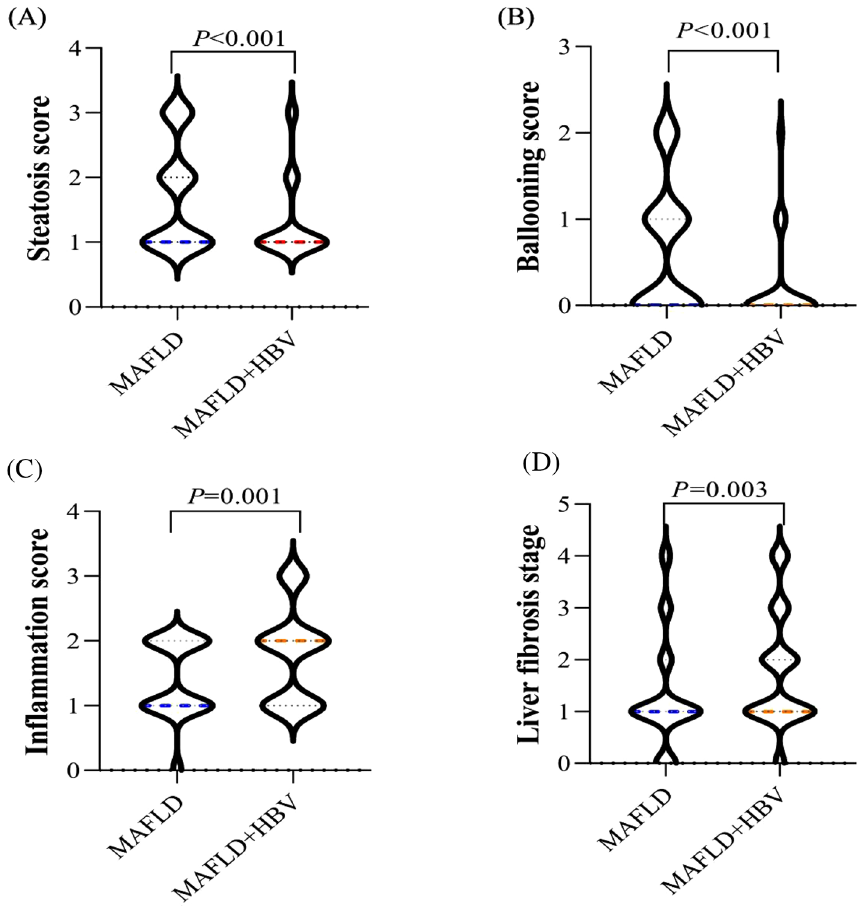
Figure 2. Comparison of histopathological characteristics between metabolic dysfunction-associated fatty liver disease with and without hepatitis B virus (HBV) infection. ( A ) Comparison of hepatic steatosis score segregated by HBV infection; ( B ) comparison of ballooning score segregated by HBV infection; ( C ) comparison of inflammation score segregated by HBV infection; ( D ) comparison of fibrosis stage segregated by HBV infection.